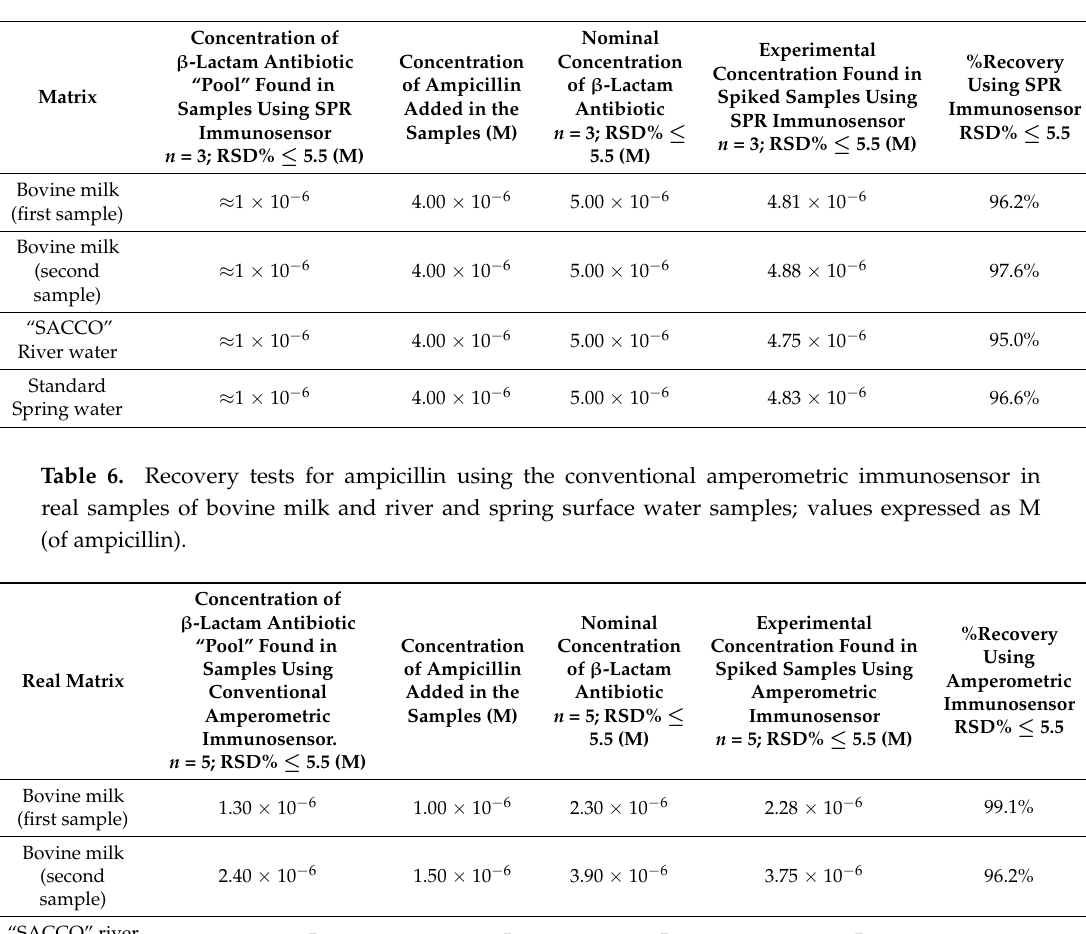
Table 5. Recovery tests for ampicillin using the SPR immunosensor in real samples of bovine milk and of river and spring water samples; values expressed as M (of ampicillin).